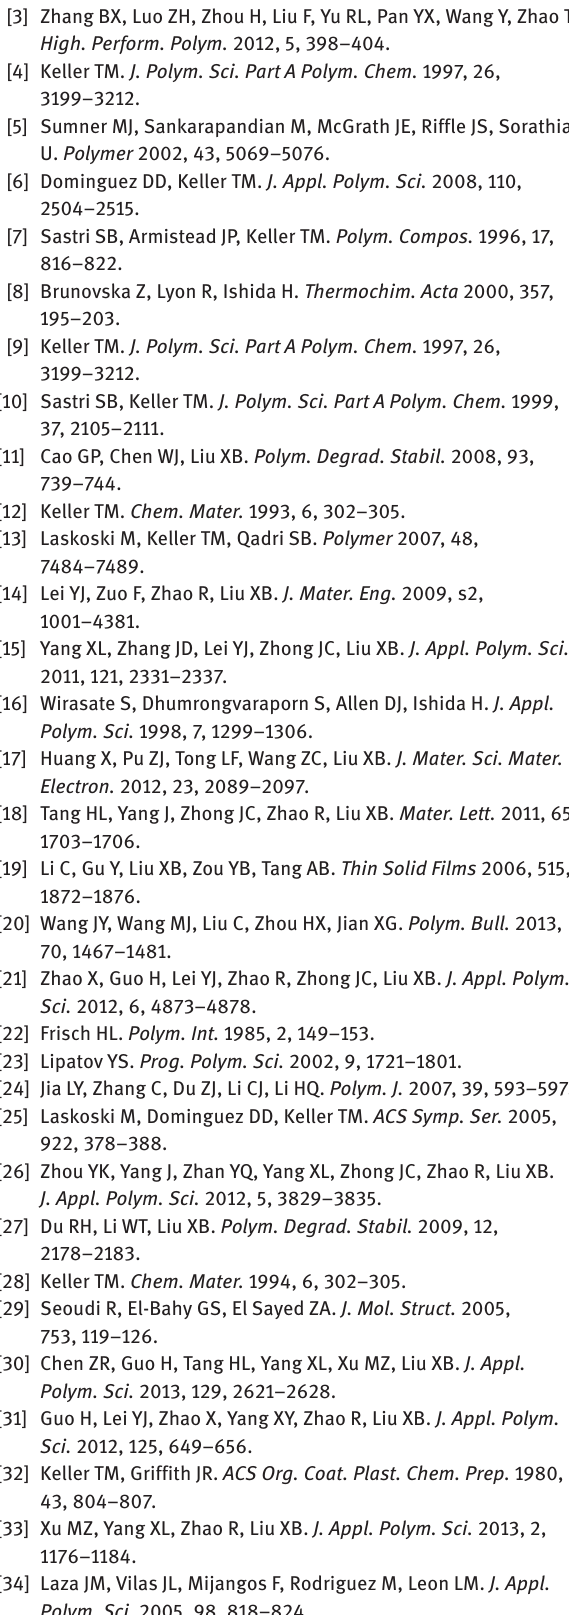
Figure 11C and D, the fracture surface of Figure 11C was very smooth, suggesting good compatibility of BAPh/ PEN-OH polymers. However, there existed a large amount of small gaps and these small gaps had a uniform distri- bution in Figure 11D. The small gaps were the unreacted PEN-OH, which had now been dissolved in the solvent of NMP. According to the FTIR and SEM results, phthalo- cyanine ring and triazine ring, the unreacted small mol- ecules, and the PEN-OH chain wound up in each other to form the IPN structure (Figure 11). The addition of PEN-OH can increase the mechanical properties of BAPh/PEN-OH polymers. The SEM results were consistent with the curing behavior and mechanical